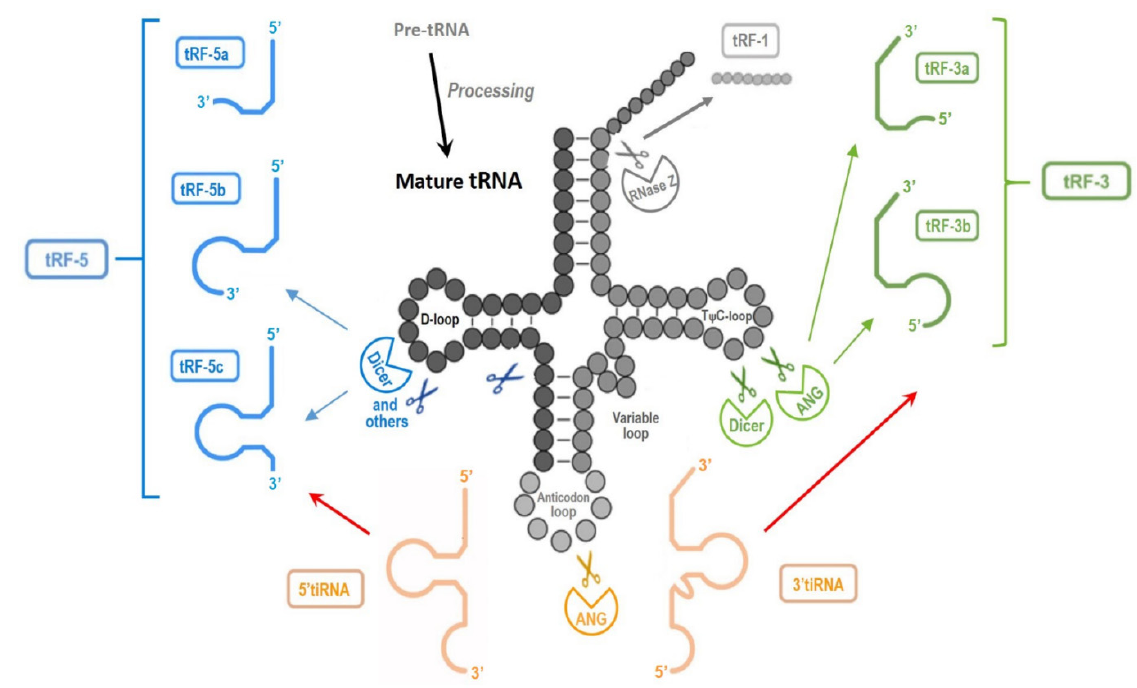
Figure 2. tRNA degradation producing different tRNA-derived fragments, either from pre-tRNA or from mature tRNA. During tRNA processing, RNases remove the pre-tRNA transcripts. tRF-1s (gray) are produced by the RNase Z cleavage of pre-tRNA. Then, mature tRNA contains multiple modified nucleosides and can be cleaved in the anticodon loop by angiogenin (ANG) to produce tiRNA-5 and tiRNA-3 series (orange). Then, a tRF-5 series is produced by the RNase III Dicer, and/or by other actors, from the 50- ends of mature tRNAs (cyan): these enzymes cleave the substrate either at the D-loop region or in sites located between it and the anticodon-loop. Instead, a cleavage in the T ψ C-loop operated by Dicer or by ANG results in the production of the tRF-3 series (green). Both tRF-5 and tRF-3 may also be processed from the tiRNA-5 and tiRNA-3 series (red arrows).